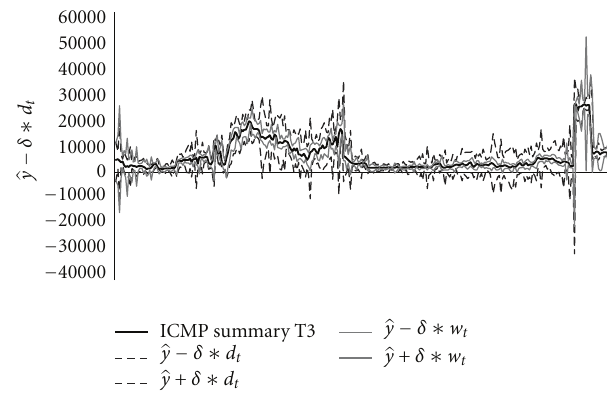
Figure 1: Sample fragment of series (308 observations, that is, 2.14 hours) ICMP in T3 network (from [6]) with daily thresholds and weekly thresholds for the scaling factor =